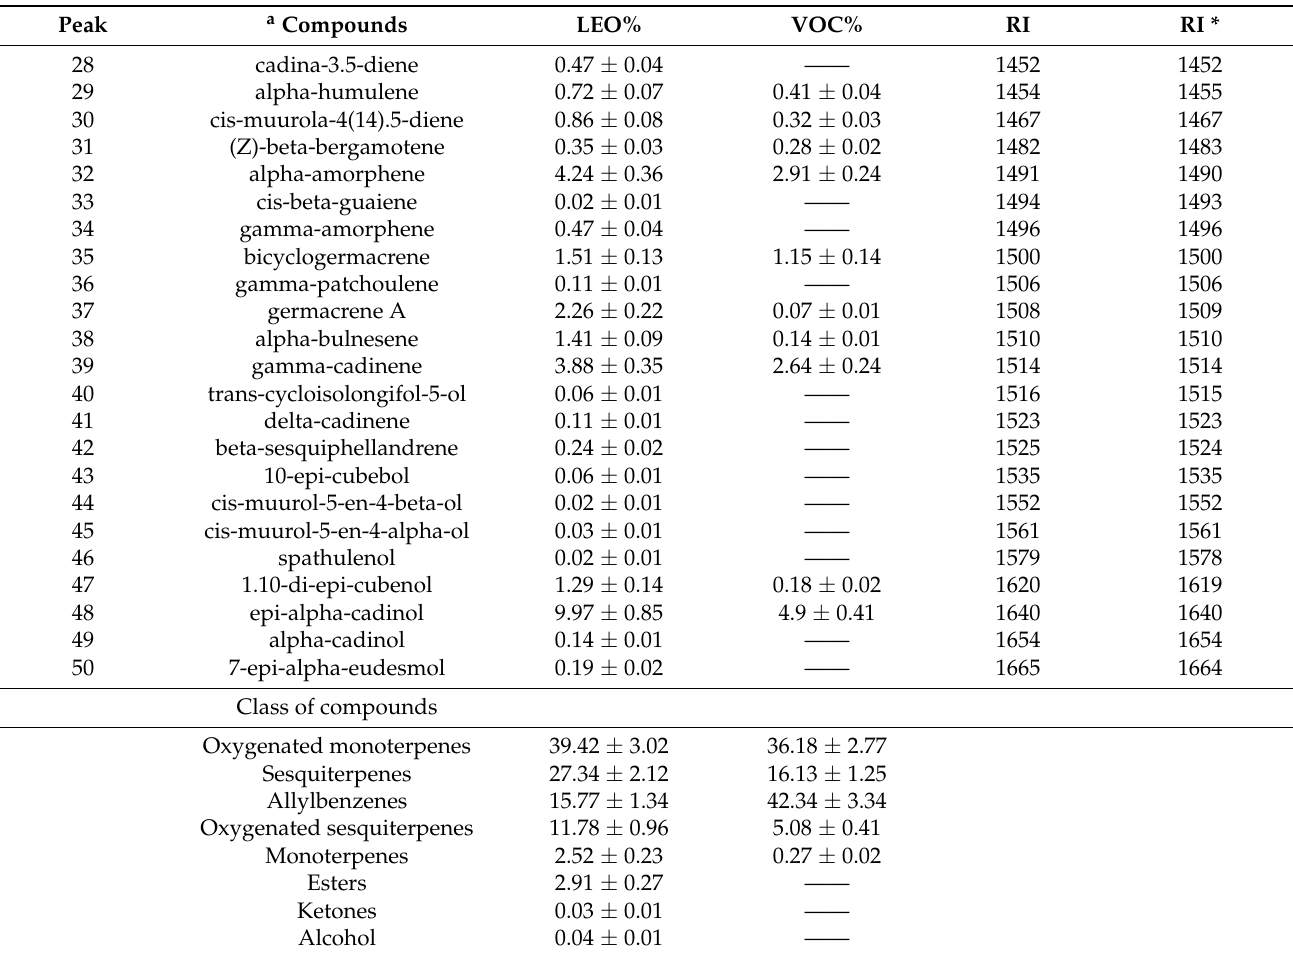
a Compounds are listed in order of their elution from a HP-5 column. Values are means of three determinations ± SD. RI: retention indices on HP-5 column, experimentally determined using homologous series of C 8 -C 30 alkanes. RI *: retention indices from the